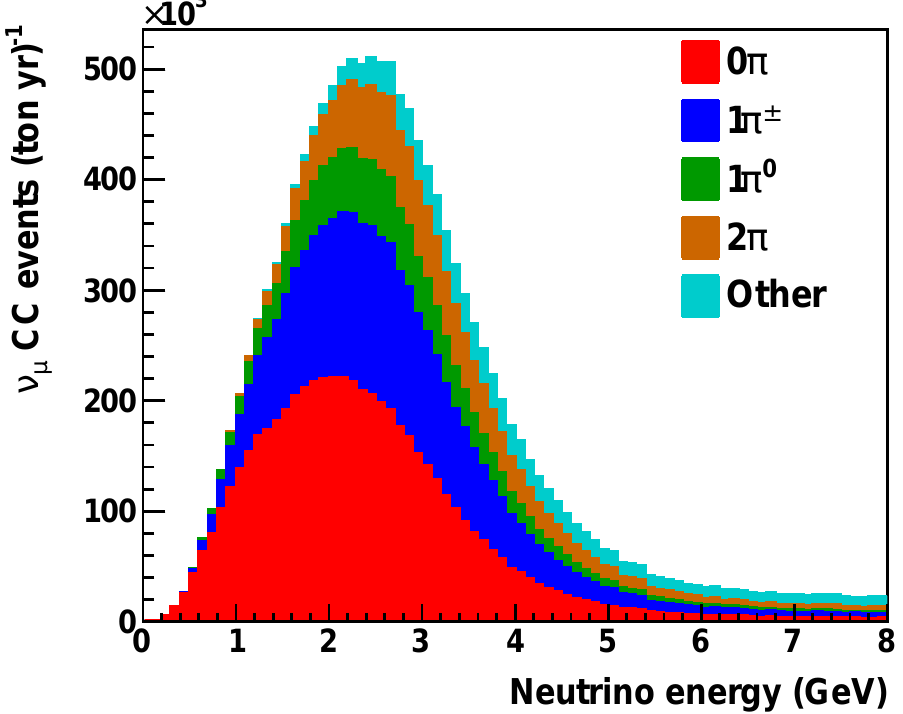
Figure 147. CC ν µ event rates on argon by interaction type expected in the DUNE ND. The simulation corresponds to 1.97 10 21 protons on target in the forward horn current mode (one spill per second × for a